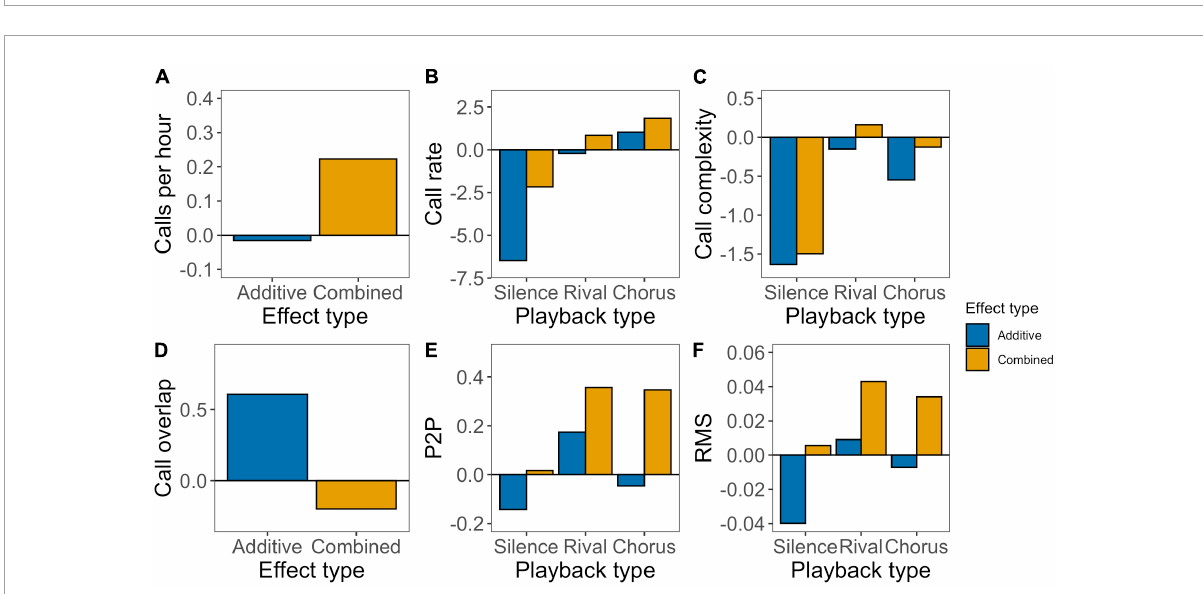
FIGURE4 Expected additive effects (the sum of the observed single effects, blue), and the observed combined effects (orange) of light and noise treatments in different playback types (silence, rival and chorus). Estimates are obtained from the models including interaction between light and noise treatment and are not back transformed. (A) Total number of calls. (B) Number of calls per minute. (C) Number of chucks per minute. (D) Percentage of calls overlapping with the played rival call. (E) Peak-to-peak amplitude of whole call. (F) RMS of whole call. See text and Supplementary Table 8 for